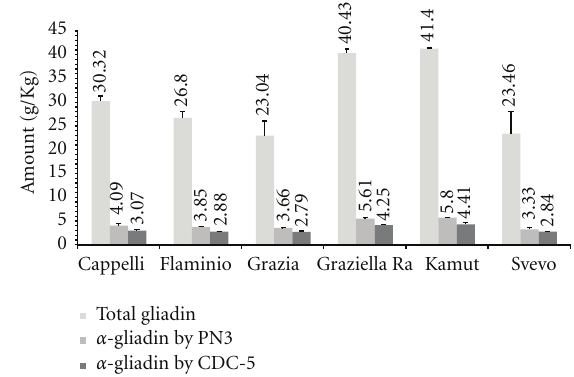
Figure 1: Total gliadin and α -gliadin determination by indirect ELISA. Total gliadin was assessed by a commercial kit (Immuno- tech); α -gliadin was evaluated using anti-p31–49 (PN3) and anti- p56–75 (CDC-5) mAbs. Results were read o ff a semilogarithmic calibration curve, constructed as the dependence of measured absorbance values (vertical axis—linear scale) of corresponding calibrators (standard Sigma—gliadin), range 0–1,000 ng/mL (hor- izontal axis-logarithmic scale); values are reported as mean ± SD from three independent